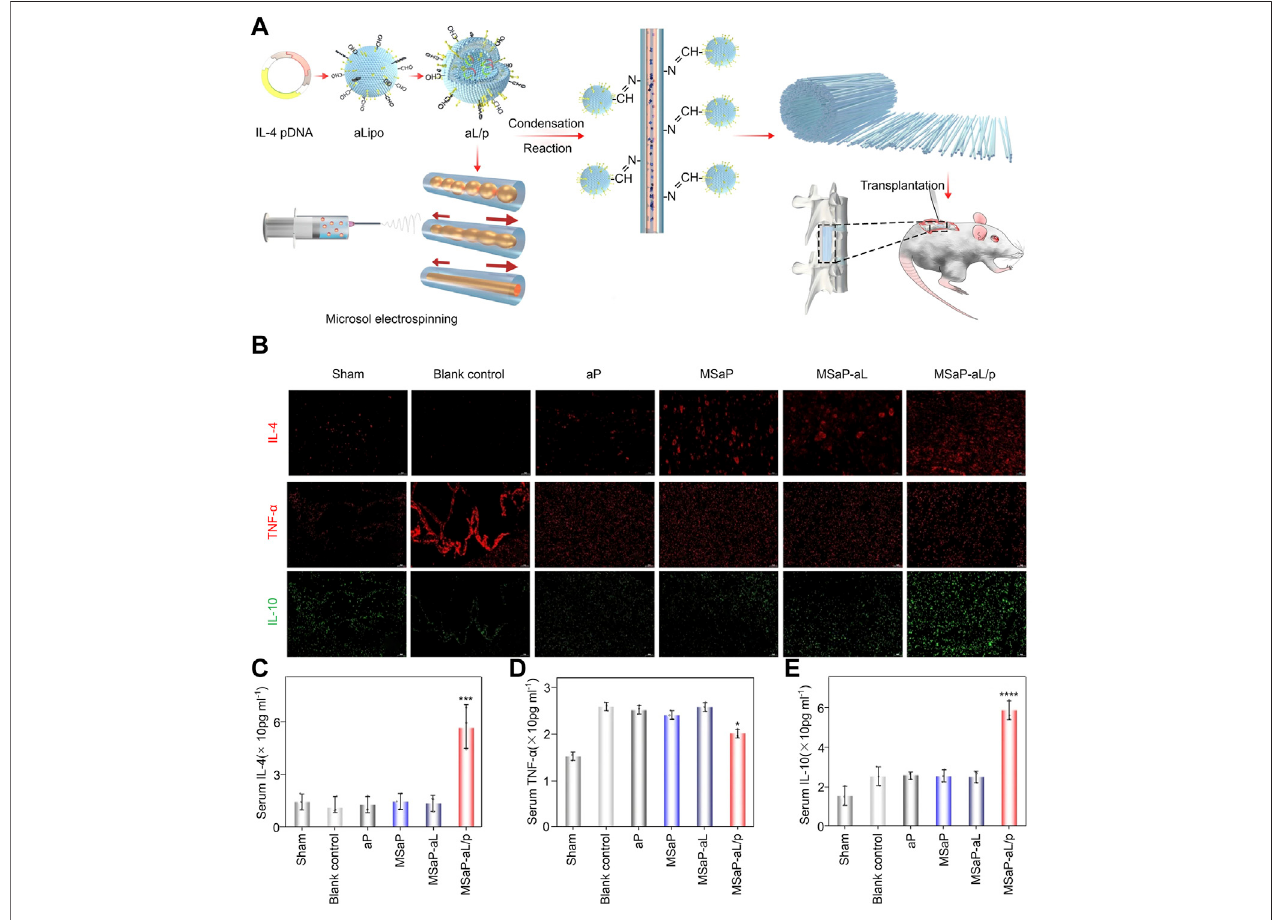
FIGURE 5 | Biomaterials containing anti-in fl ammatory factors. (A) Schematic diagram and application method of composite material. (B) Evaluation of immunomodulation of composite materials on the 7th day after operation. ELISA method to detect serum IL-4 (C) , tumor necrosis factor- α (D) and IL-10 (E) levels. Reproduced with permission from